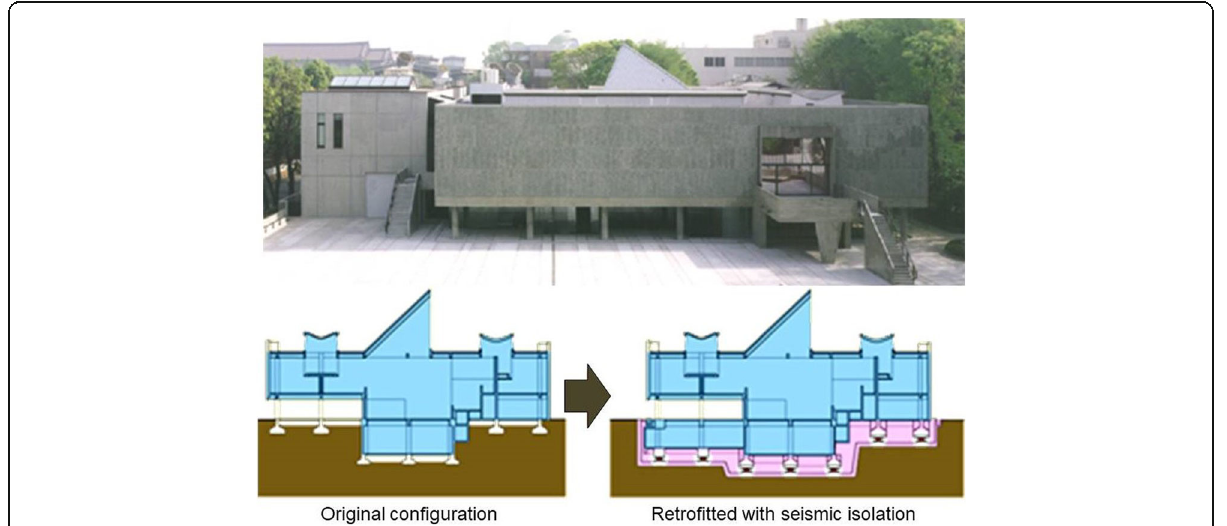
Fig. 13 Seismic isolation retrofit of the National Museum of Western